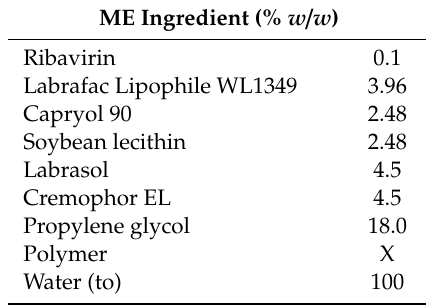
Table 1. Composition of ribavirin-loaded bioadhesive multiple W / O / W microemulsion